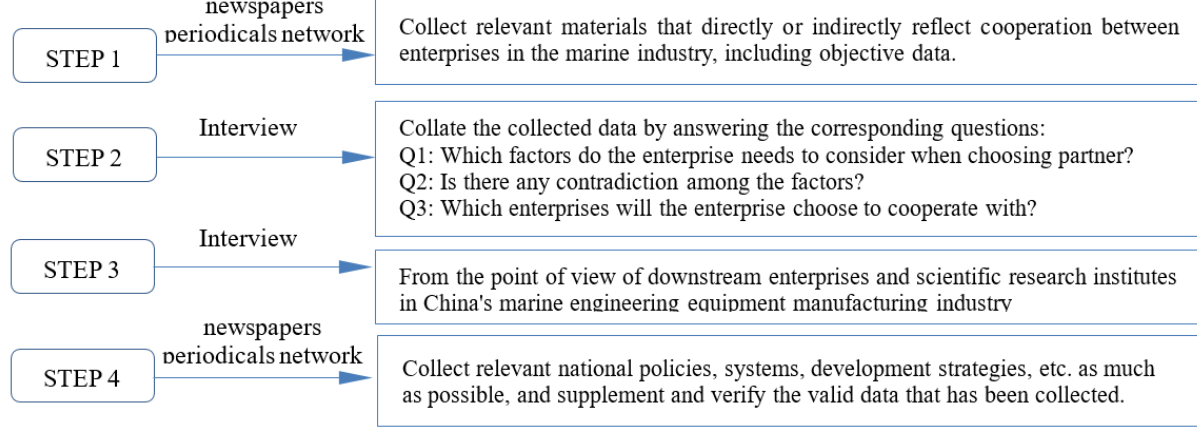
Fig. 1 Data collection and processing steps based on Grounded